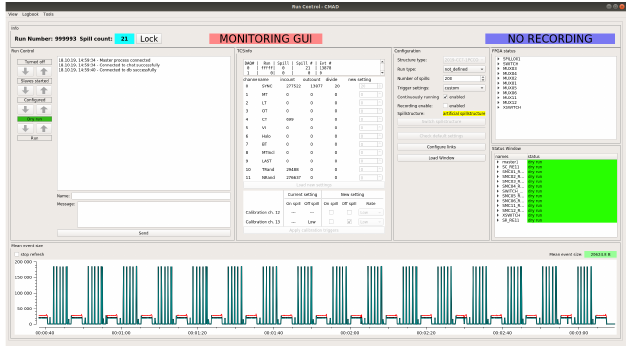
Figure 3. The main window of the Run control GUI. The main features present are buttons to initiate state transitions of the DAQ system, trigger and event rate display, DAQ state machine state display and FPGA registry